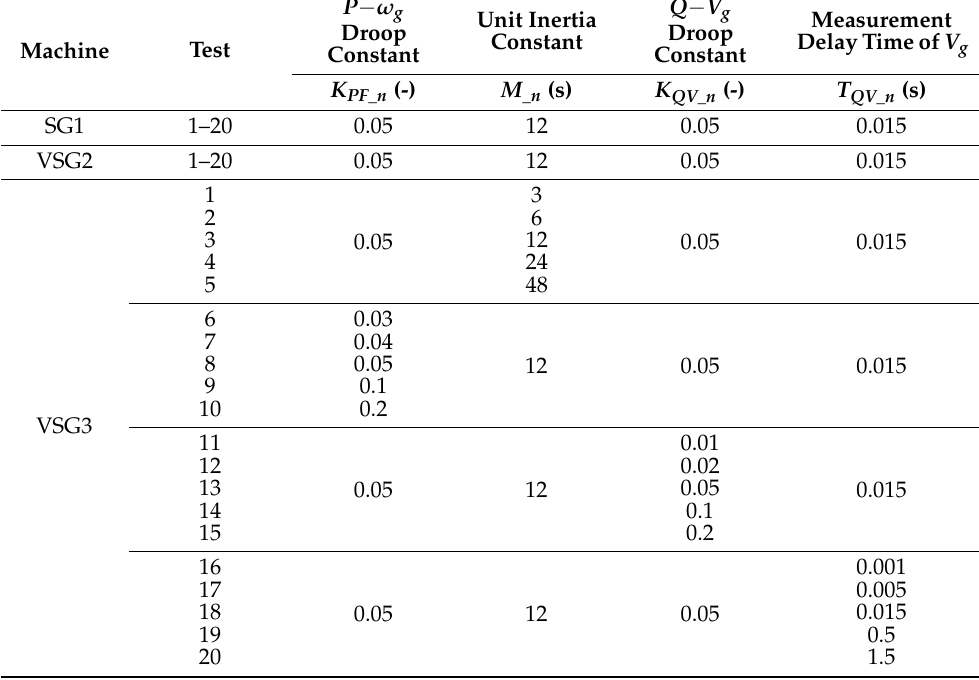
Table 1. Machine constants and control